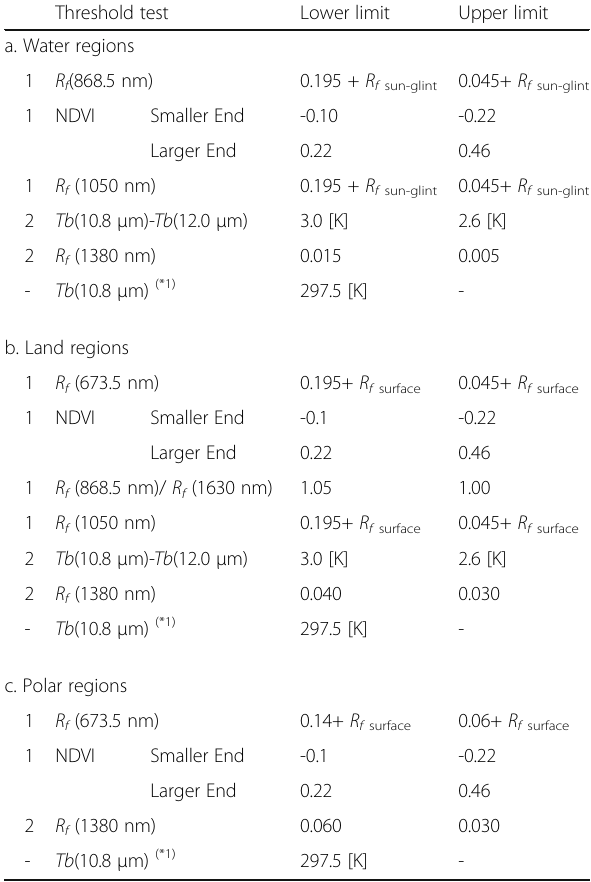
Table 3 Thresholds for cloud screening with SGLI. a: Over water, b: Over land, and c: Over polar regions. R f and T b are reflectance and brightness temperature, respectively Threshold test